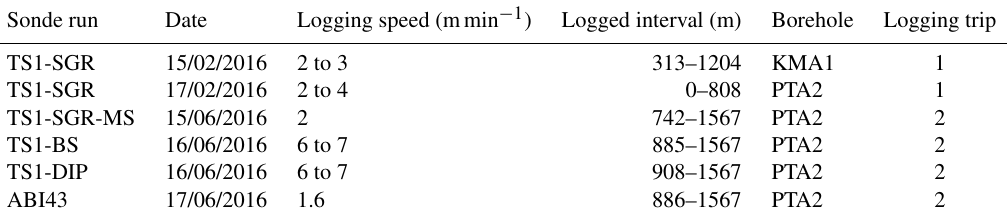
Table 3. Summary of all logging runs from the